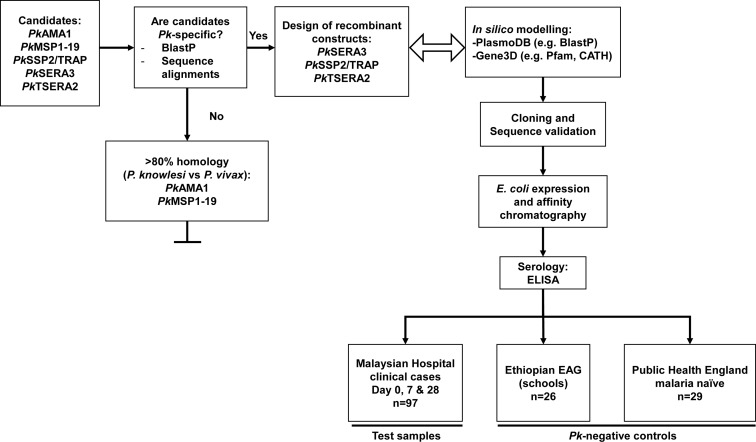
Flowchart summarising the experimental strategy used in the identification and validation of the P. knowlesi-specific candidates.